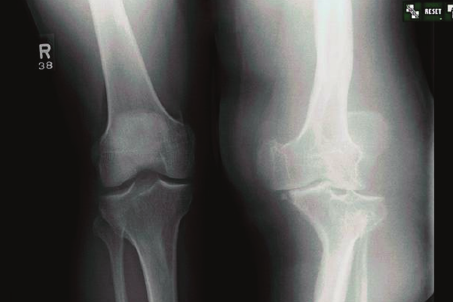
Figure 2: Left knee demonstrates grade 4 OA and varus deformity of left leg.